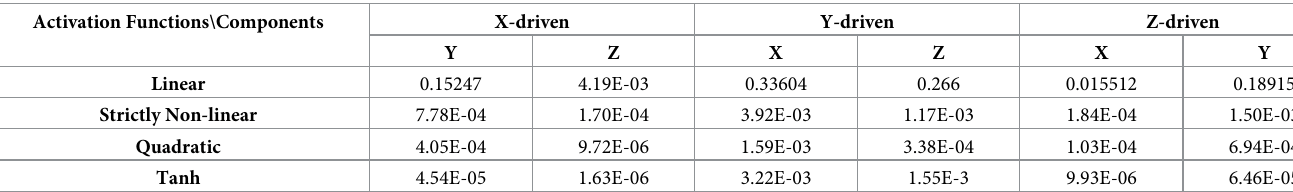
Table 6. Mean square error (MSE) for controlled system in Experiment set 2. Activation